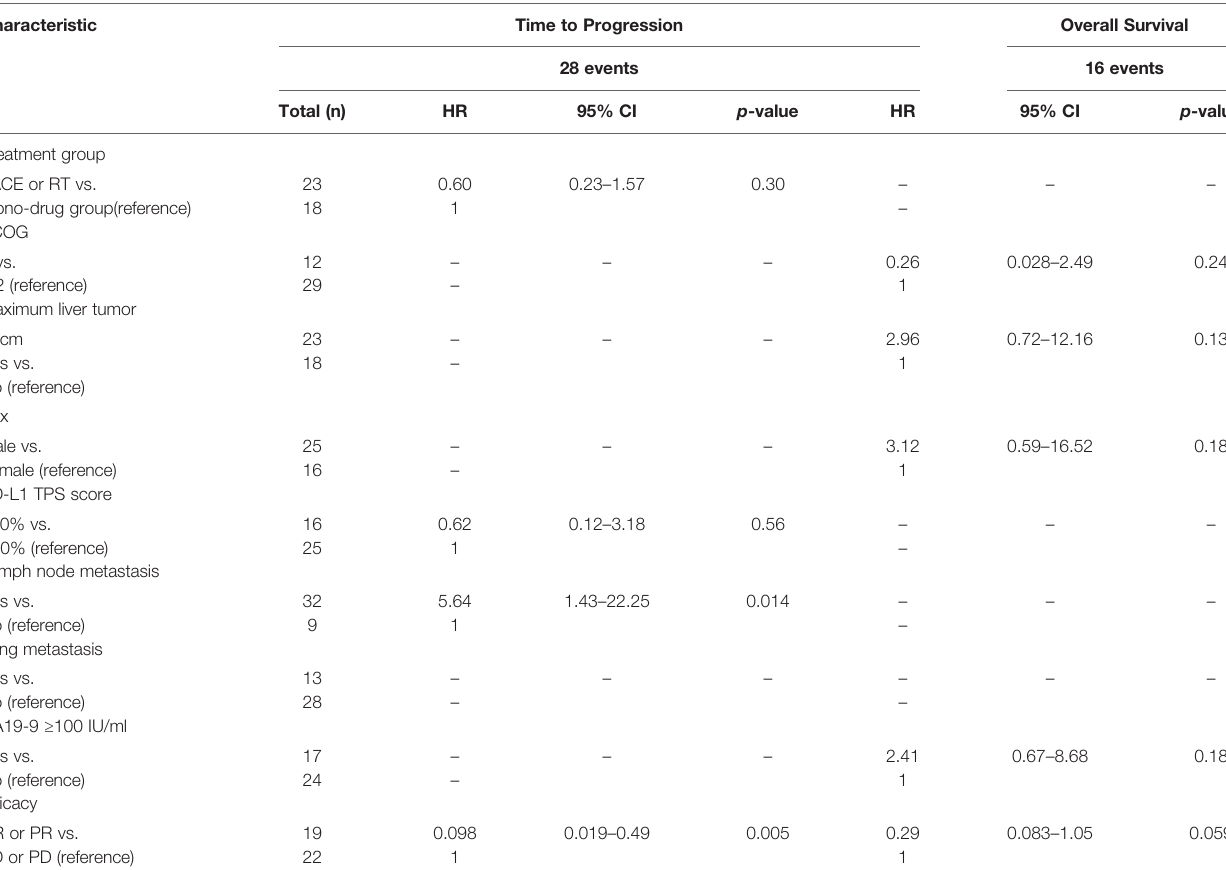
TABLE 2 | Multivariable Cox proportional hazard model for TTP and OS. Characteristic